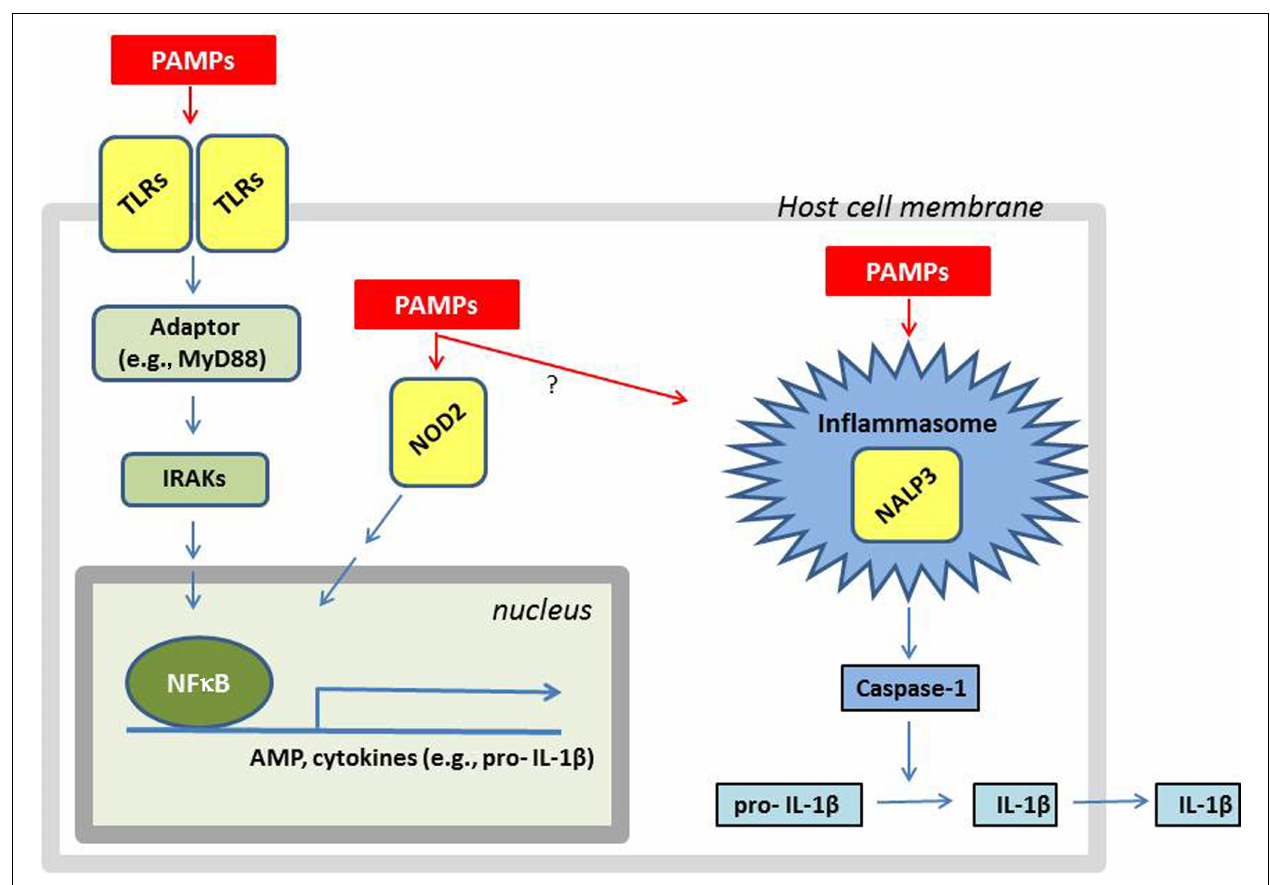
α -hemolysin) are recognized as PAMPs by the intracellular receptors NOD2 and NALP3, respectively.The activation of NALP3 results in the assembly of the inflammasome, resulting in caspase-1 activation, followed by IL-1 β processing and secretion.The activation of NOD2 can result in activation of NF κ B resulting in AMP production, and perhaps also inflammasome assembly. Since little is known about intracellular signaling induced by MSCRAMMs, they were not included in the figure even though some of their interaction partners are